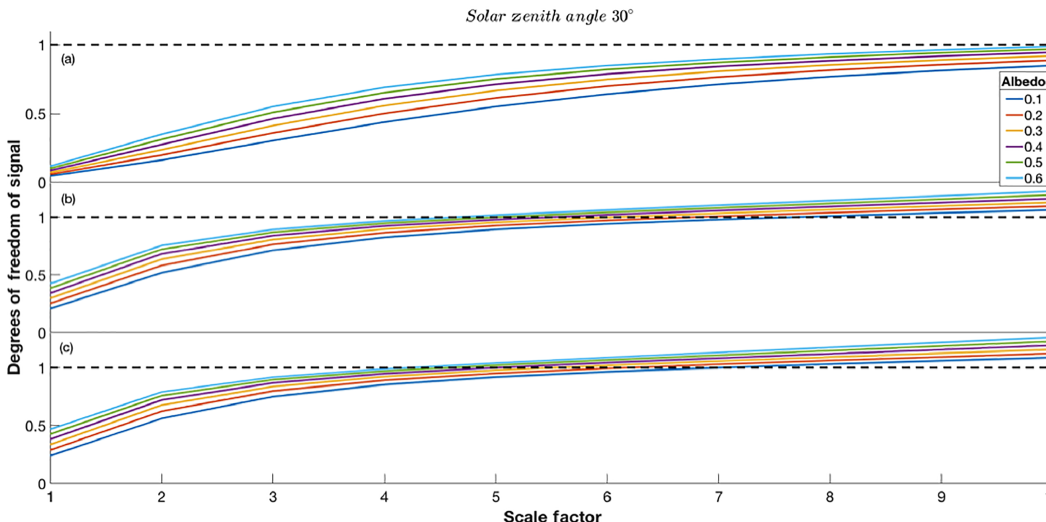
Figure 6. Degrees of freedom for signal for 13 CH 4 vs. scaling factor f for scenarios outlined in Table 3. Each coloured line represents different surface albedo conditions as shown in the key. The black dashed line represents unity DOFS: panel (a) indicates scenario 1, panel (b) indicates scenario 4 and panel (c) indicates scenario